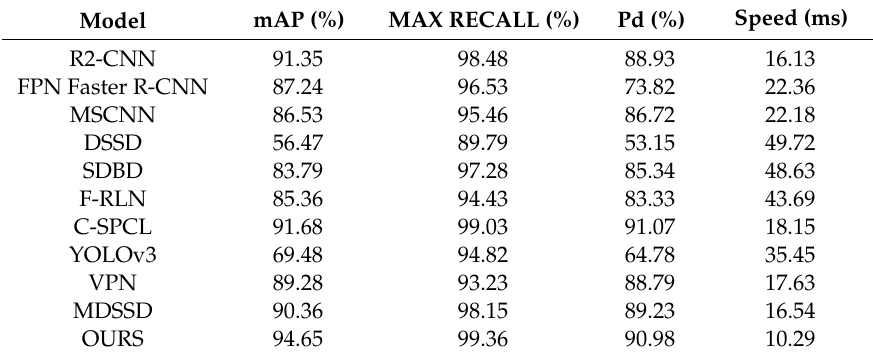
Table 5. Comparison of the object detection performance using the TGRS-HRRSD dataset.